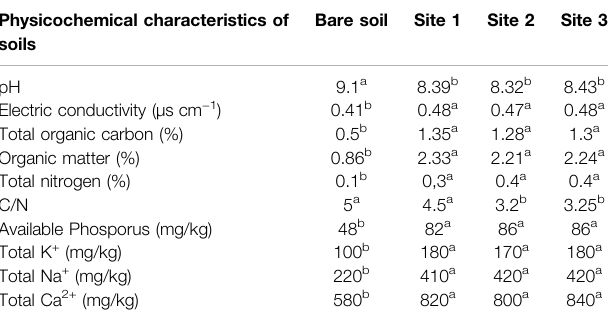
TABLE1| pH,electricalconductivityandmineralcontentsoftherhizosphericsoils of Acacia cyanophylla and the bare soil (control) in the sand dunes of